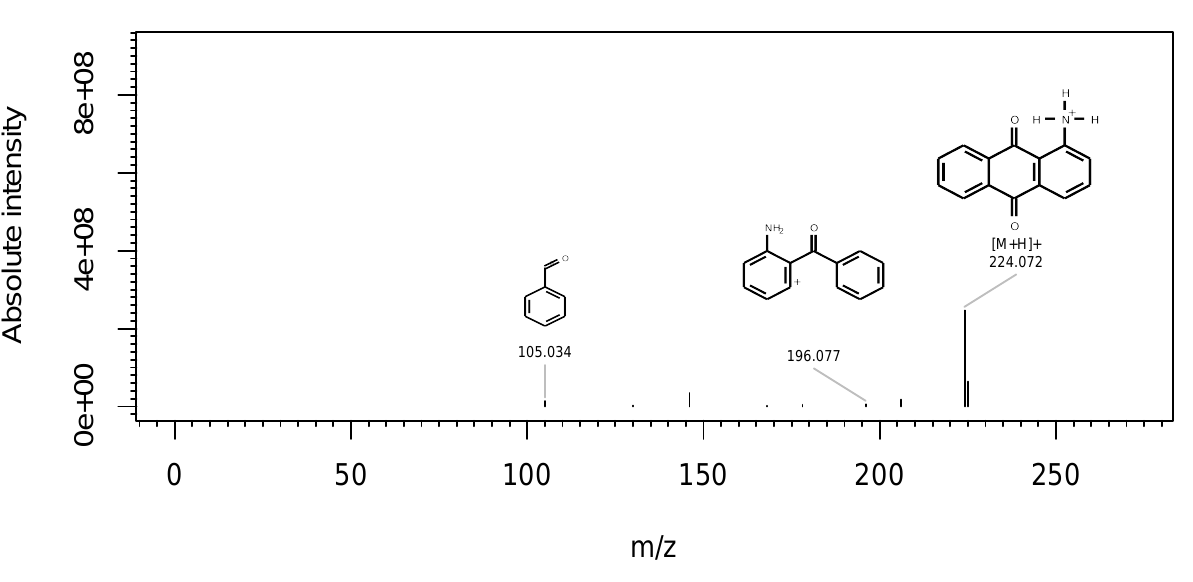
Figure A7. Challenge 10: annotated MS/MS spectrum of 1-aminoanthraquinone (ESI, positive mode).